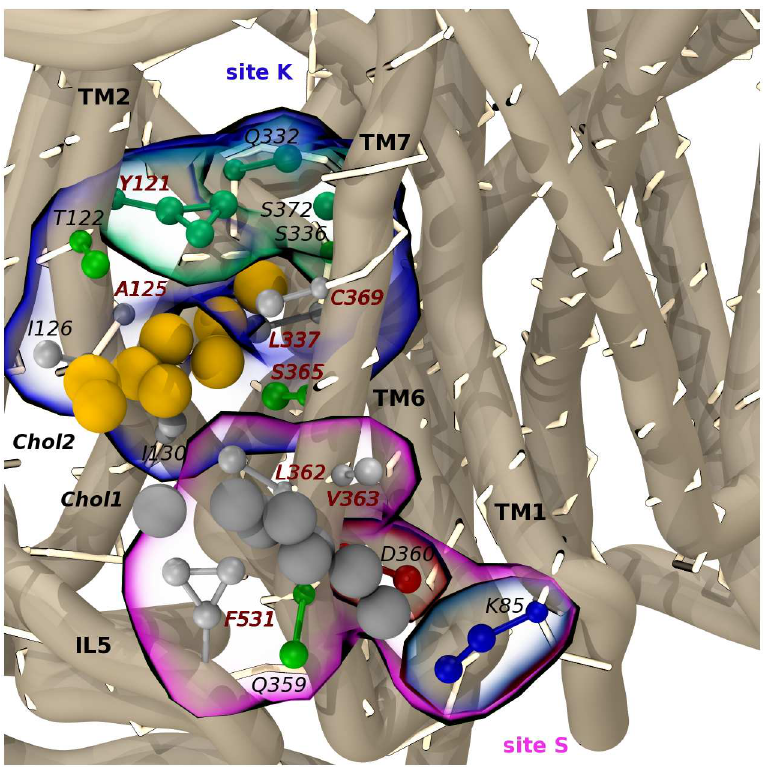
Fig 5. Sites S and K. Site S (purplecontouredsurface) and site K (blue contoured surface) boundwith two distinct cholesterol molecules(Chol1and Chol2, grey and yellow beads, respectively). Residuesof chloride site (darker green CPK representation) are contoured in green transparentsurface; N368 on TM7 faces the interior of the transporter and is not labeledin the picture. Outliers are labeledin bold (dark-redcolor). Amino acids enteringthe topology of the sites are colored by residue type. The K85-D360salt-bridge is also